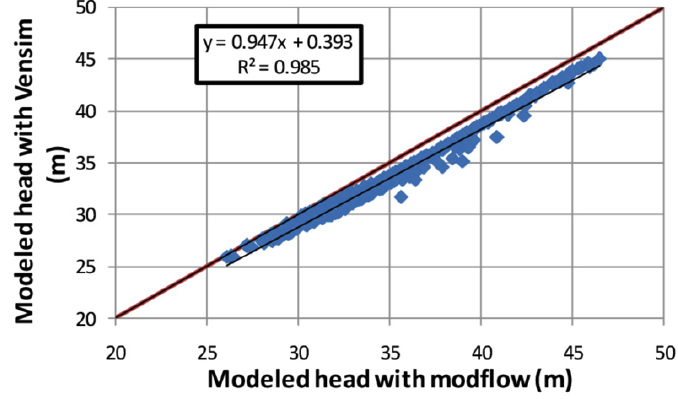
Figure 11. Correlation between MODFLOW results and VENSIM results.